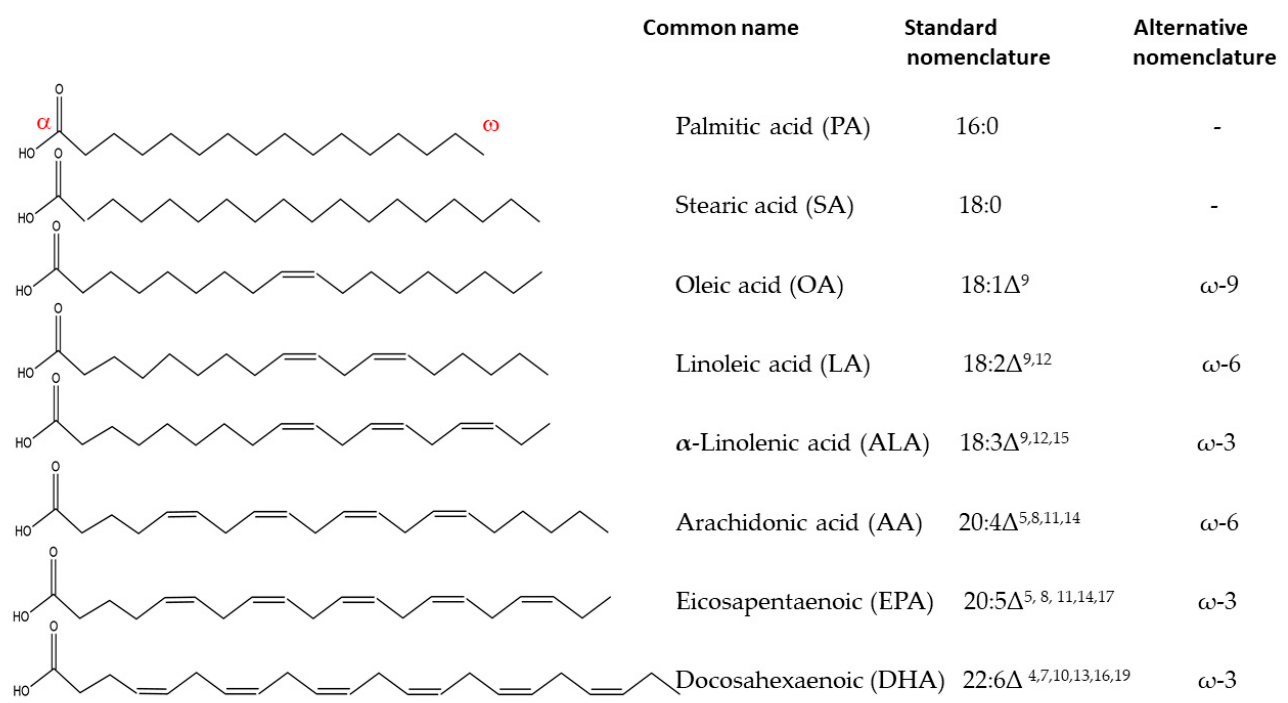
Figure 1. Fatty acids important for human health.